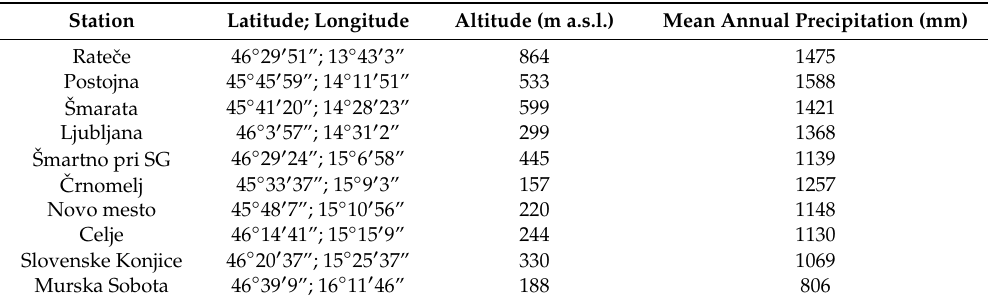
Table 1. Main characteristics of the ten analyzed rainfall stations listed based on the longitude coordinate. Mean annual precipitation values are for the period from